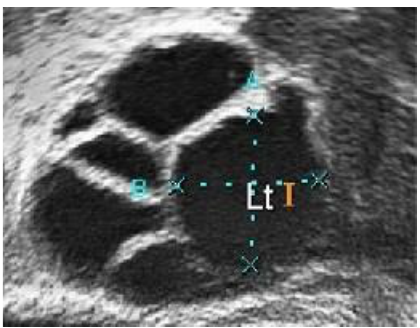
Figure 5. Ultrasound image with high intensity of light pixels.